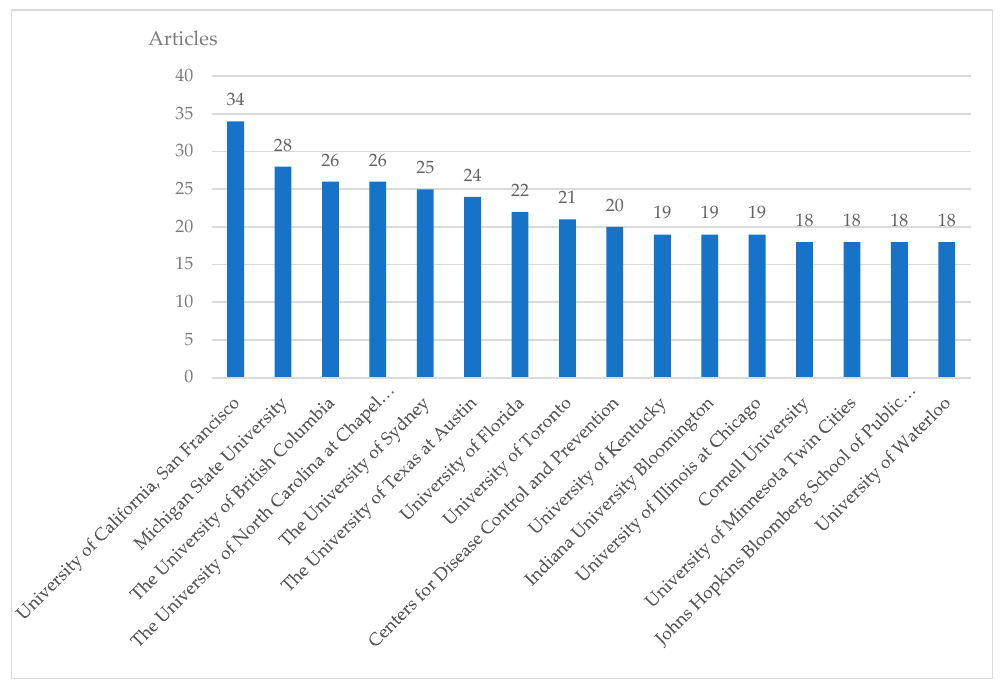
Figure 6. Authors’ affiliation.